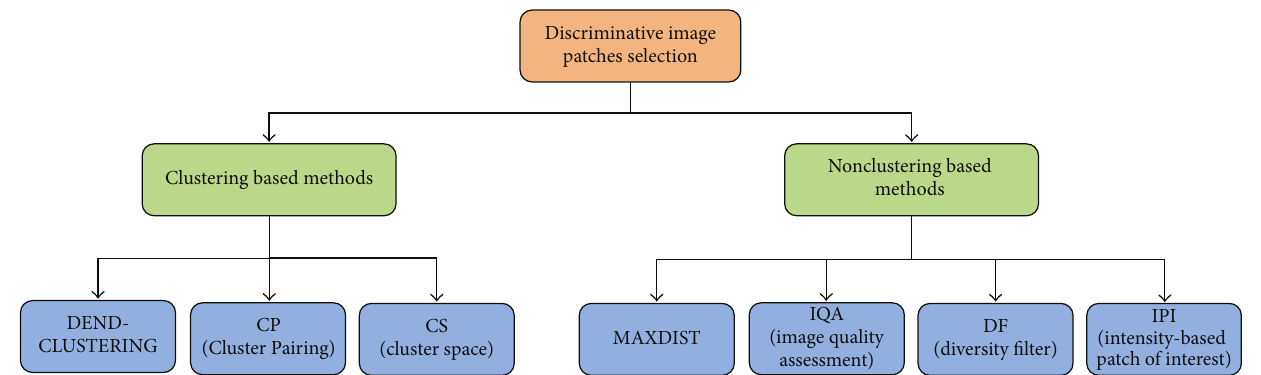
Figure 4: Classification of the seven discriminative image patches selection methods proposed in this